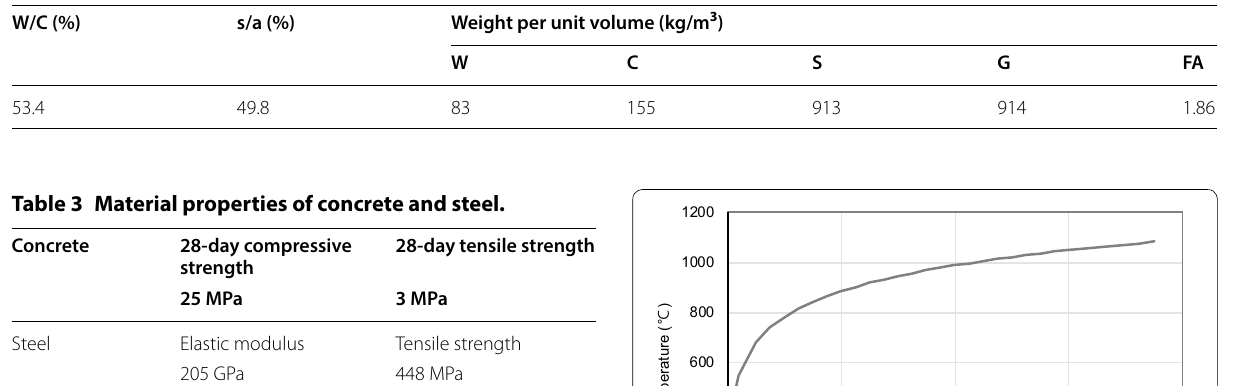
Table 2 Mixture proportion for concrete.